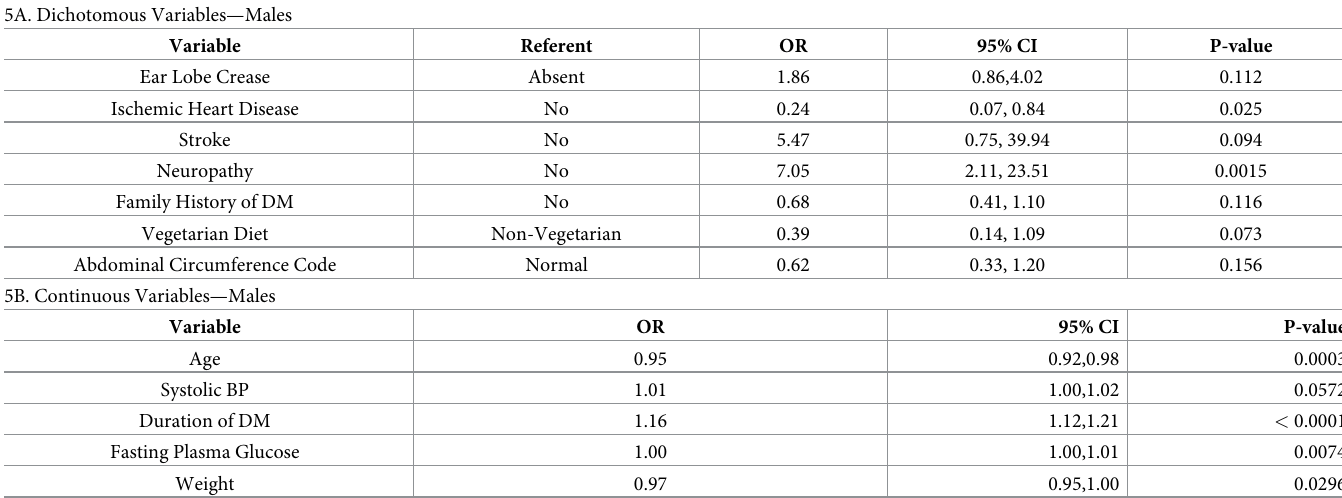
Table 5. Stepwise multivariate Sex stratified analysis of DR association–Males.